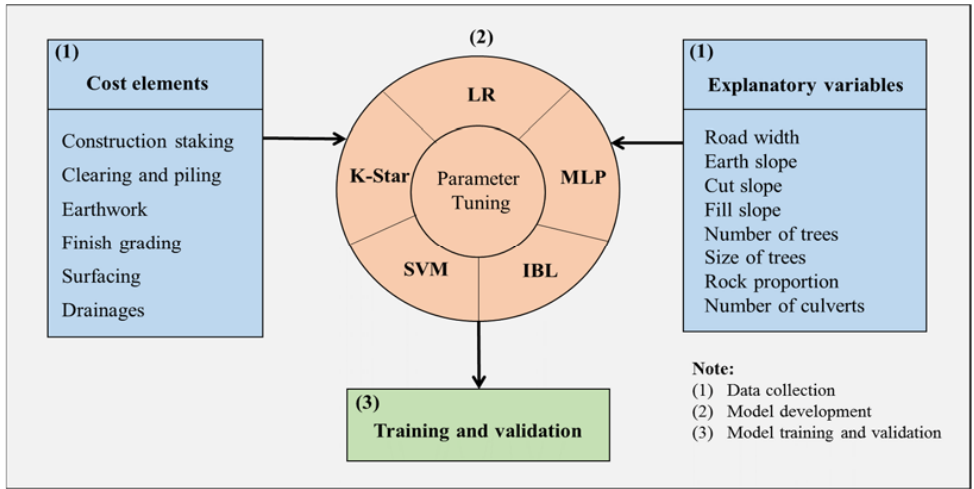
Figure 1. Flowchart of the modeling methodology adopted for cost estimation of road construction.